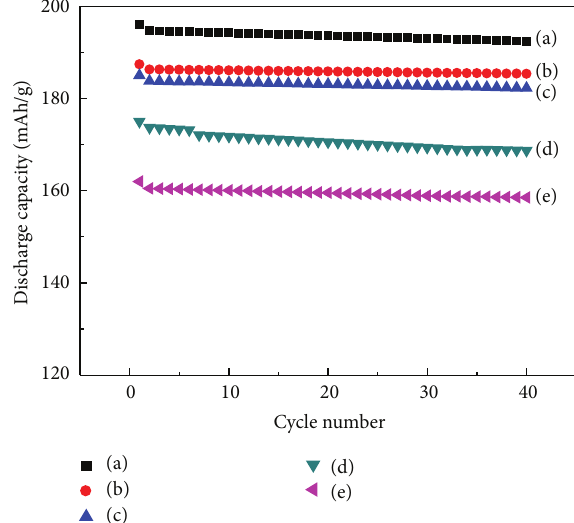
Figure 6: Discharge capacities for a Li / LiNi 0.65 Mg 0.05 Co 0.3 O 2 cell during the first 40 cycles at 𝐶/10 rate in the different voltage ranges. the presence of three peaks at different voltage positions for LiNi 0.7 Co 0.3 O 2 , which arise from multiple phase transitions CV curve for LiNi 0.7 Co 0.3 O 2 , while diminishing in intensity,